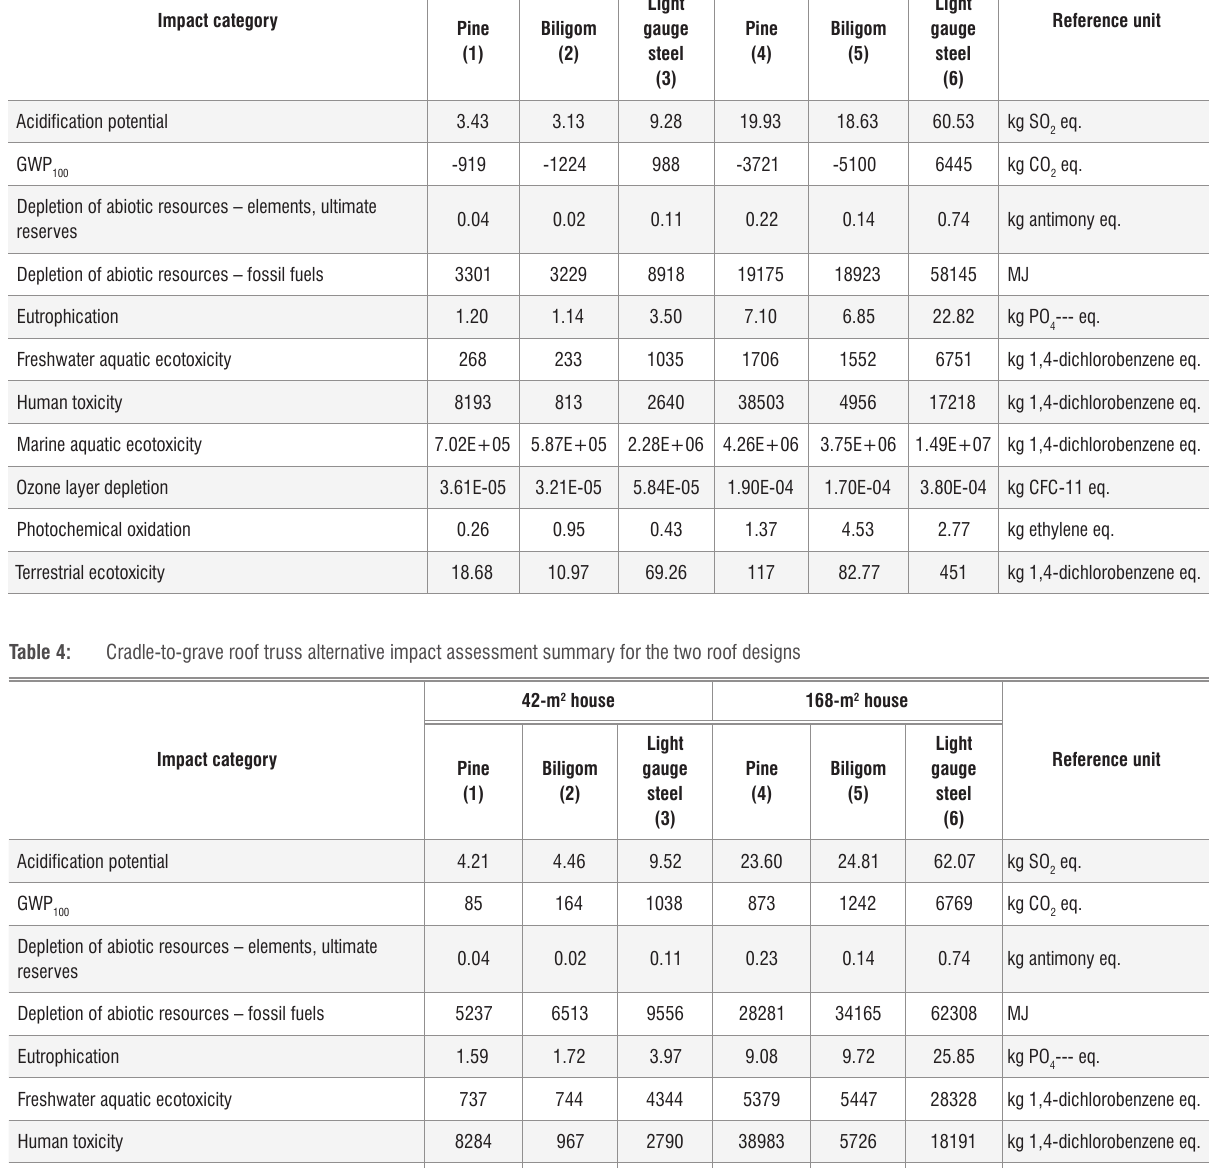
Impact category